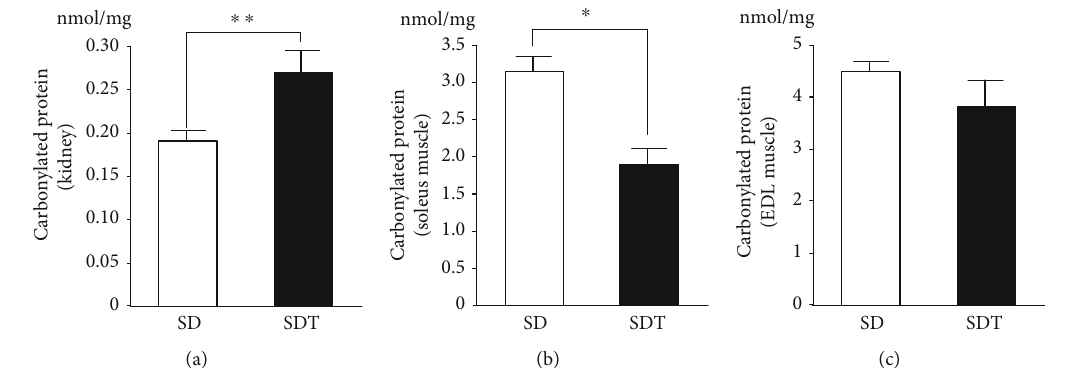
Figure 10: Expression pro fi les of carbonylated proteins in kidney (a), soleus (b), and EDL muscle (c) tissues. Values are presented as the mean ± SEM . ∗ p < 0 : 05 and ∗∗ p < 0 : 01 vs. SD rats.